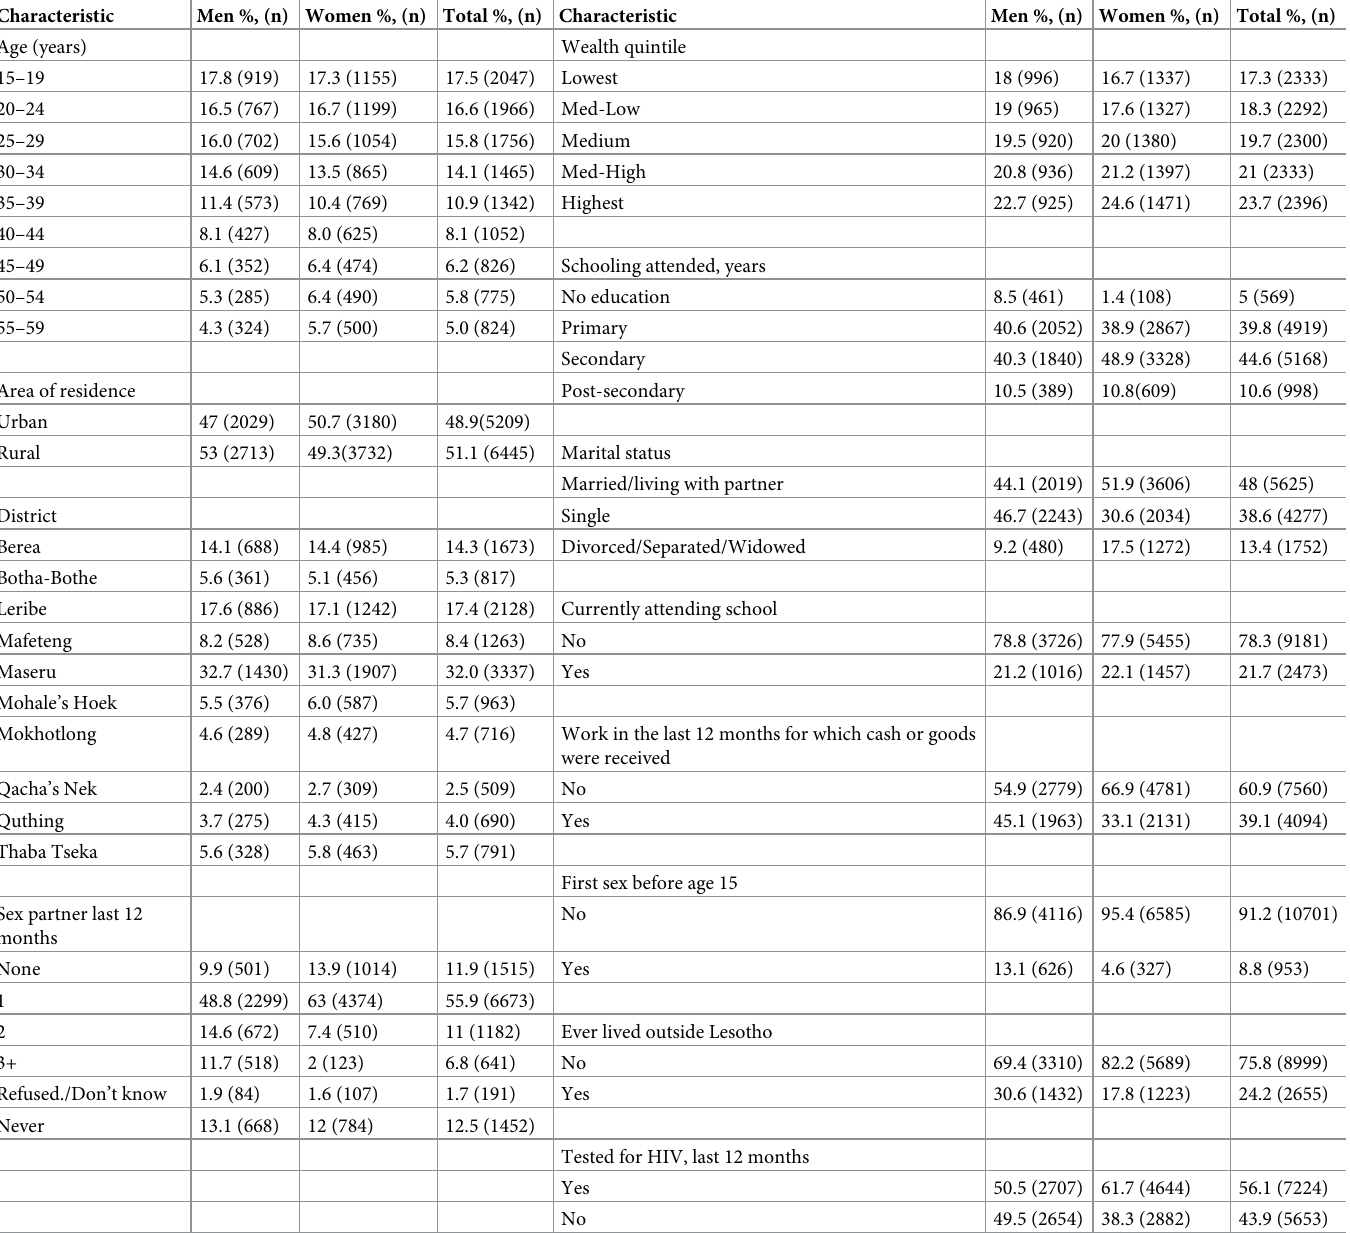
Table 2. Demographic characteristics of participants aged 15–59 years (N = 12877; men, 5361; women, 7526), Lesotho Population-based HIV Impact Assessment 2016–2017 � .